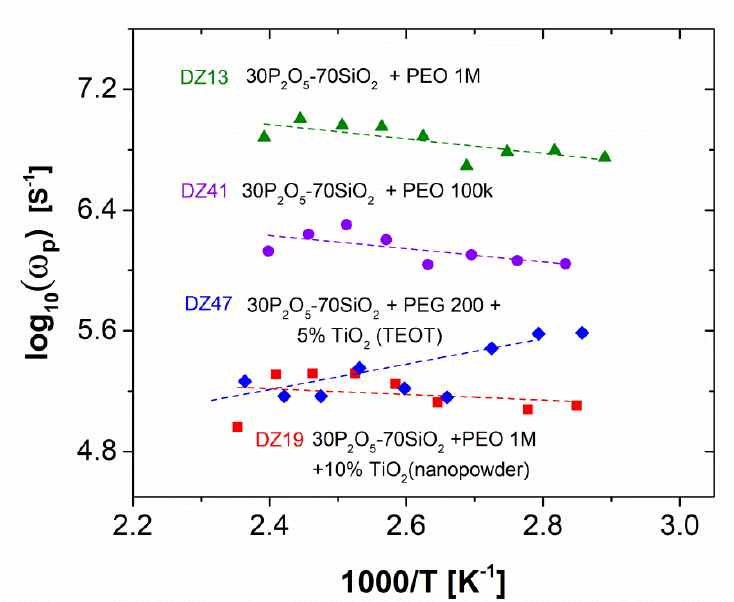
Figure 12. Jonscher’s ω p vs. temperature dependencies with reference to dielectric relaxation data compiled for the investigated series, recorded during the heating sub-cycle of PEO-doped glass compositions: (cid:78) –30P 2 O 5 -70SiO 2 + 0.5% PEO 1 M; • –30P 2 O 5 -70SiO 2 + 0.5% PEO 100 k (cid:7) –30P 2 O 5 -70SiO 2 + 0.5% PEG 200 + 5% TiO 2 (TEOT); –30P 2 O 5 -70SiO 2 + 0,5% PEO 1 M + 10% TiO 2 (nanopowder).